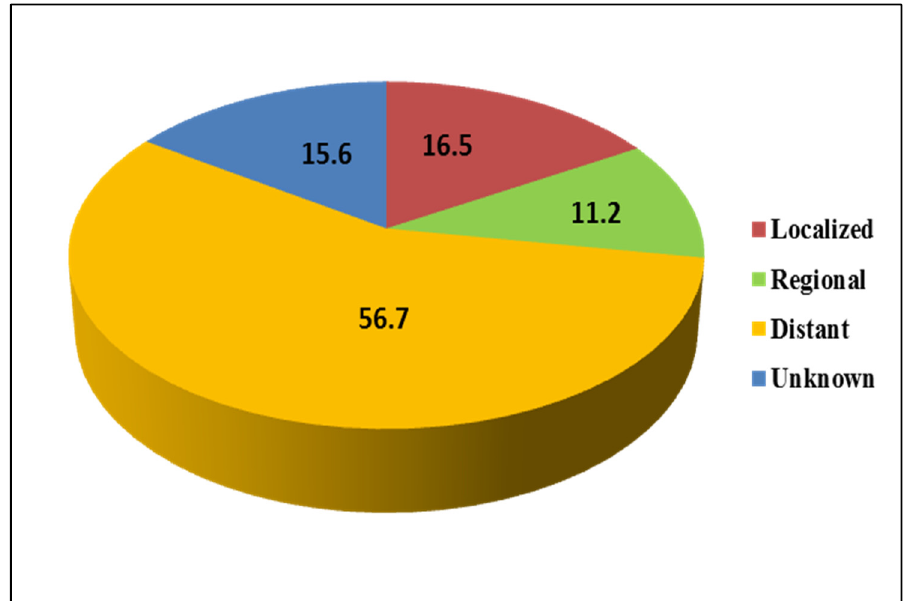
Figure 9. Overall percentage stage distribution of lung cancer in females during 2006 to 2016.